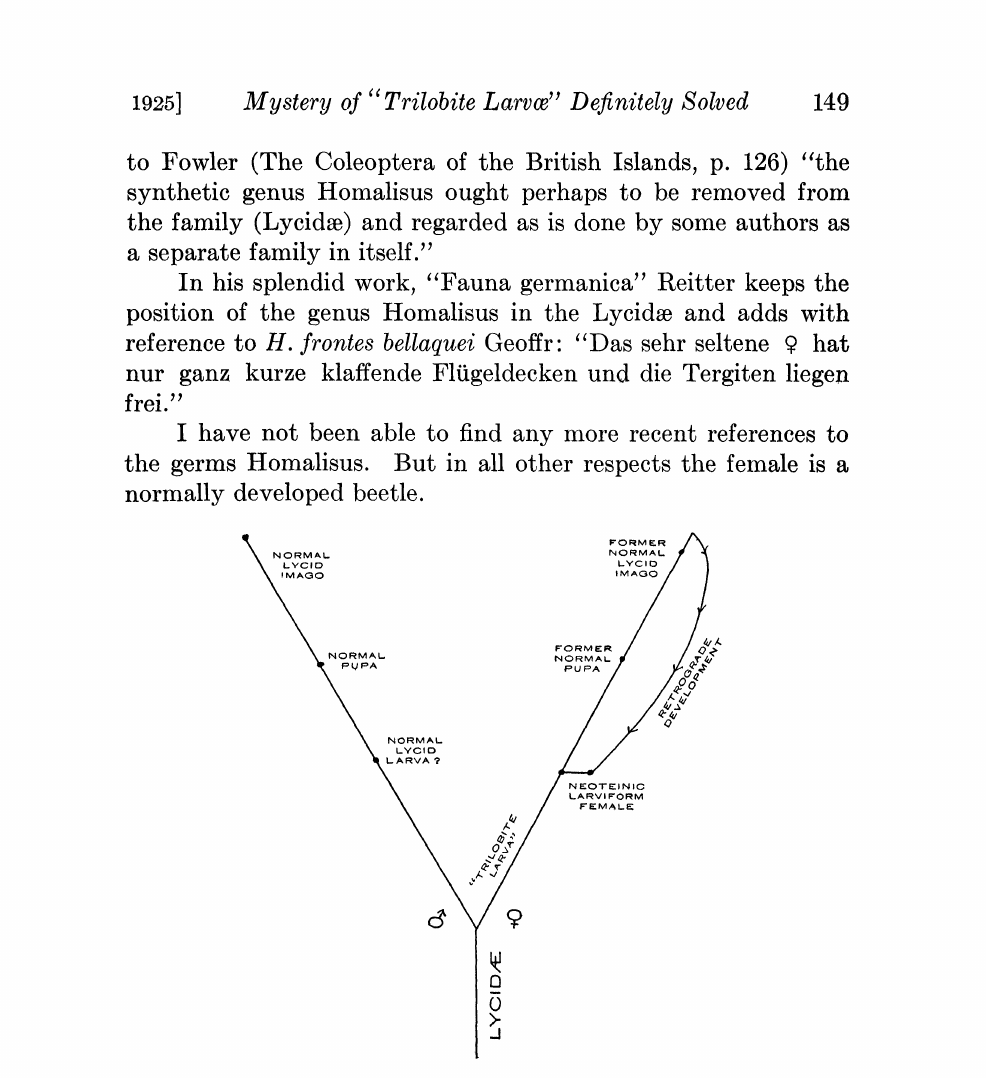
lig. 2. Diagram illustrating the types of metamorphosis in the